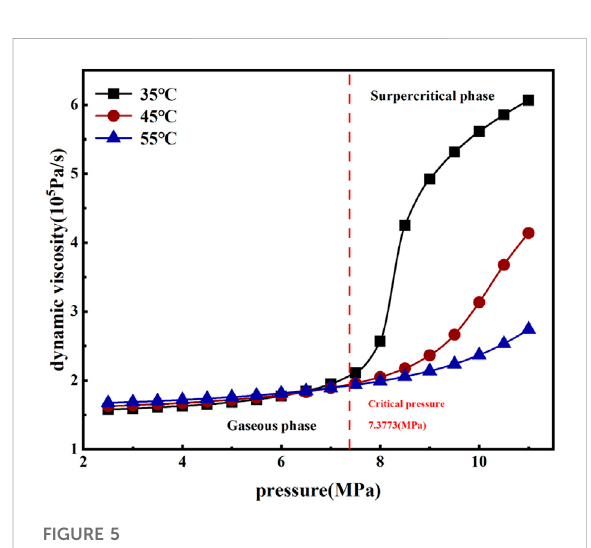
FIGURE 5 Dynamic viscosity of CO 2 varies with